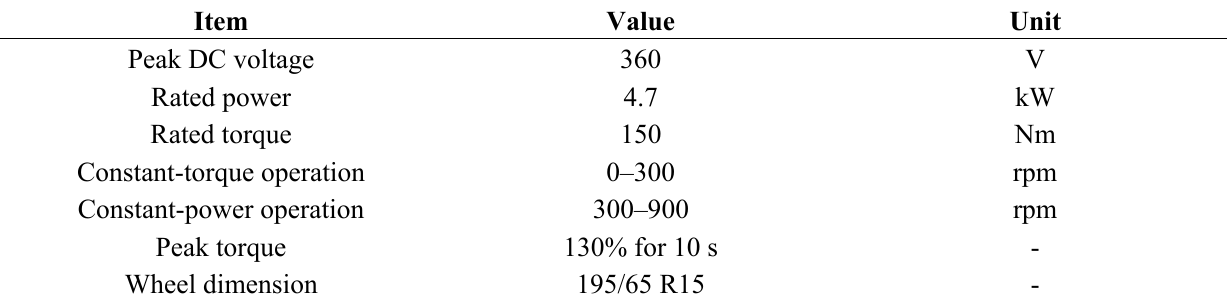
Table 1. Targeted motor specifications for the RE-EV